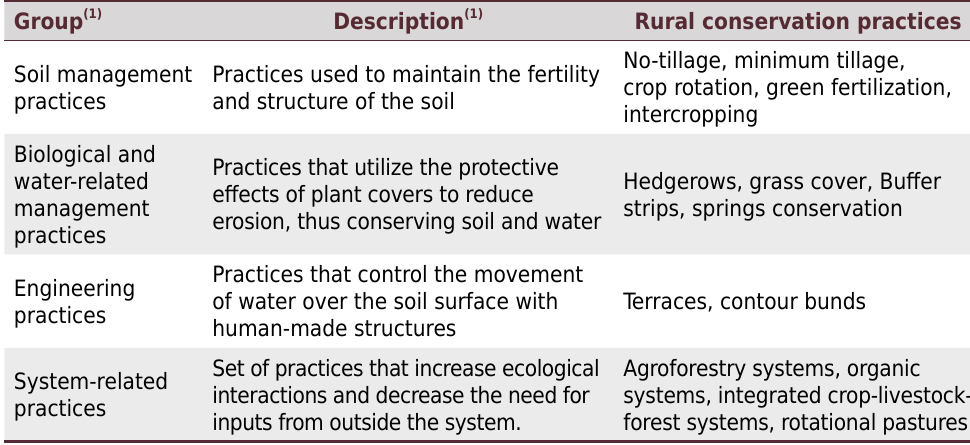
Table 2. Groups of selected rural conservation practices and their